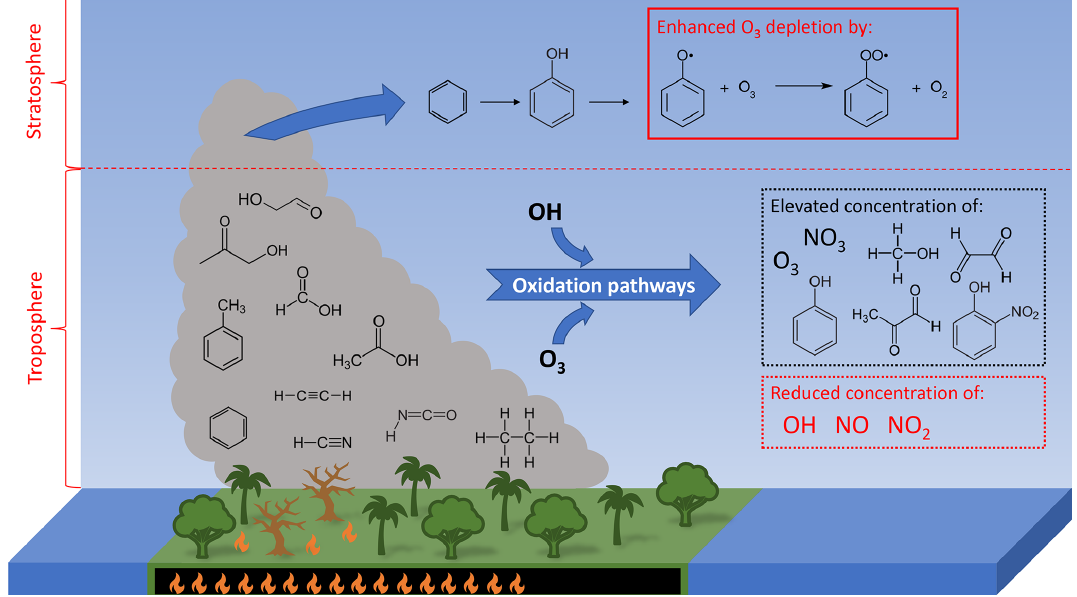
Figure 7. Illustration of the impact of VOC emissions from the Indonesian peatland fires on the atmospheric composition.